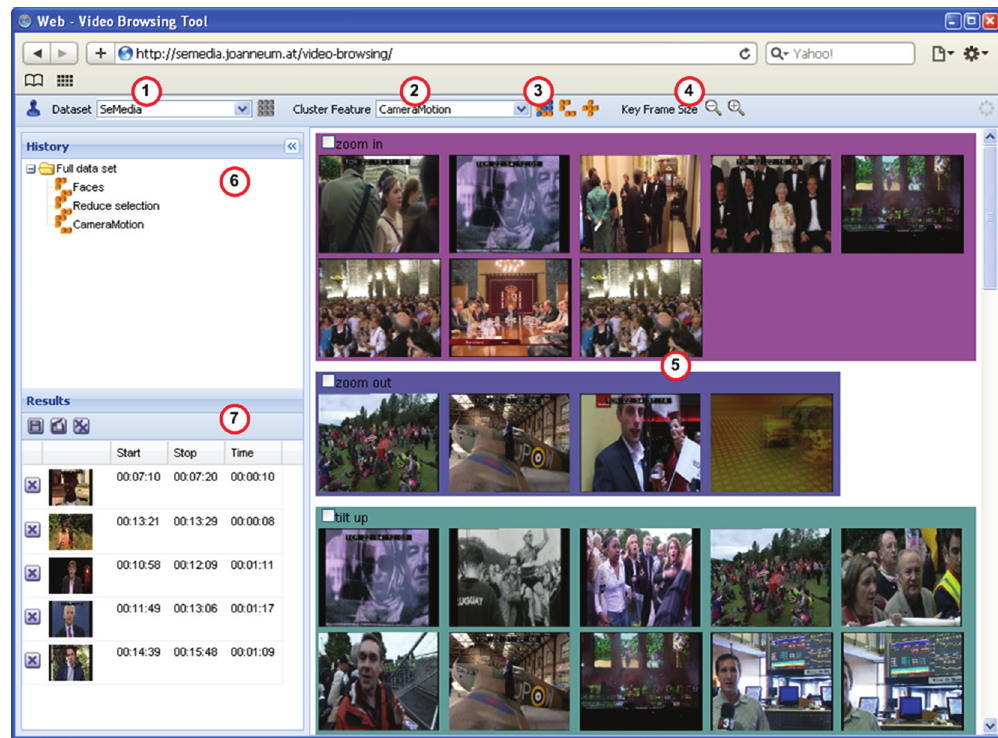
Figure 5: Screenshot of the Web-based video browsing